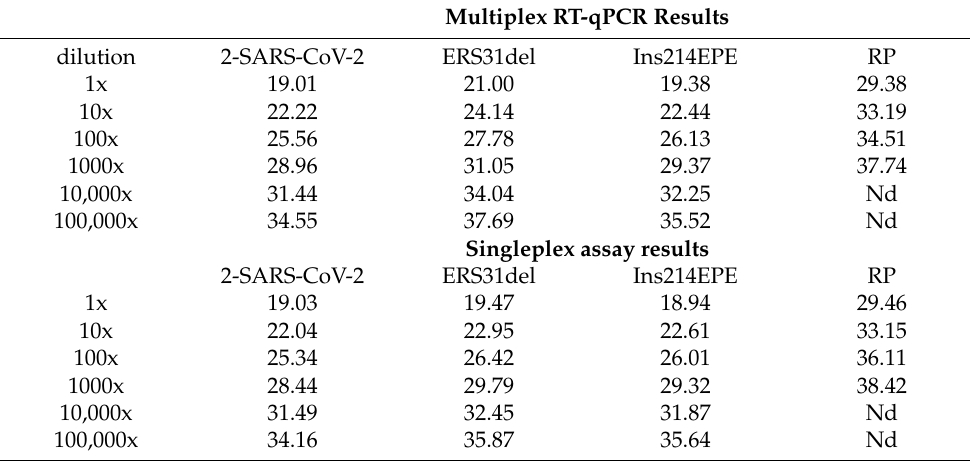
Table A3. Comparison of qPCR results of the same SARS-CoV-2 BA.1 sample tested in 6 dilutions with multiplex and single-plex RT-qPCR assays (a single reaction in one tube, 4 tubes for each dilution of the sample). “Nd”—Not